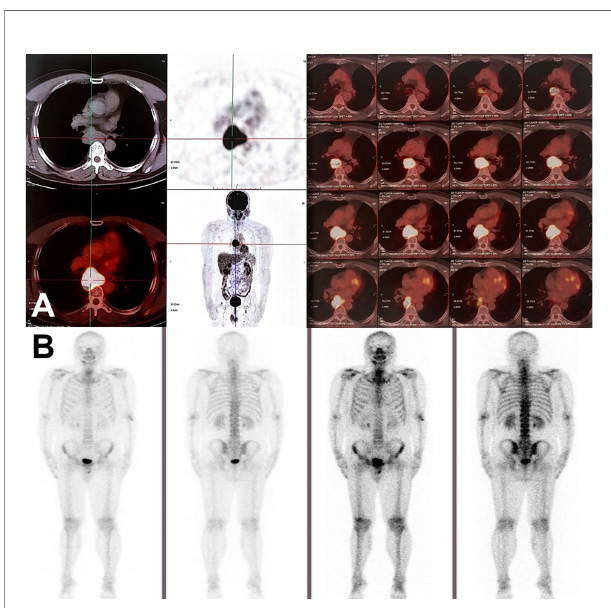
FIGURE 2 | Radiographic fi ndings on PET/CT and radioactive bone scan. (A) PET/CT scan in June 2020 showed the enlargement of mediastinal lymph node station 7 with max SUV 22.2, suggesting mediastinal lymph node metastasis. No visible primary pulmonary parenchymal focus but postoperative changes in the left lung. (B) No distant metastasis on radioactive bone scan.